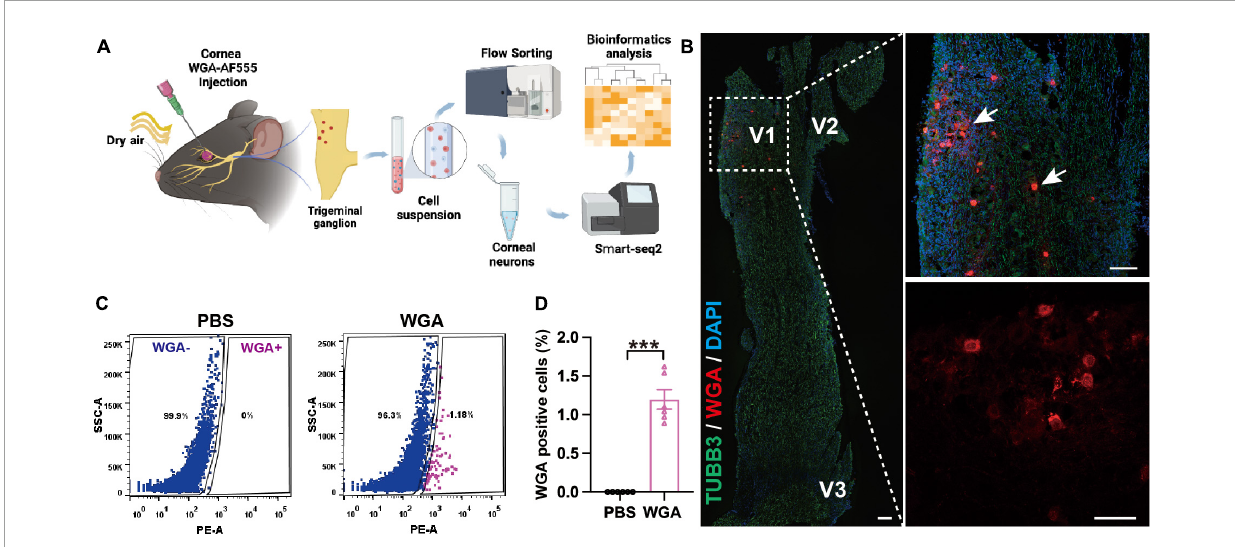
FIGURE3 Trigeminal ganglion (TG) corneal neurons in environmental dry eye disease mice sorted for RNA sequencing. (A) Procedure flowchart showing, that after corneal WGA-AF555 injection, the mice were given CDS treatment and then TGs were FACS sorted, followed by corneal neurons RNA sequencing application. (B) Representative images of retrograde WGA-AF555 (red, arrows) corneal neuron cell bodies in TG on day 3. Scale bars: 100 µ m. (C) Representative FACS images of WGA-AF555-positive corneal neurons in TG on day 3. Blue: WGA-AF555 negative cells, pink: WGA-AF555-positive cells. (D) The proportion of WGA-AF555-positive cells from a total TG population in the corneal WGA-AF555 injection ( n = 6) and PBS injection ( n = 6) groups. Data are represented as mean ± SEM; *** P < 0.001; WGA-AF555: wheatgerm agglutinin-Alexa Fluor 555, CDS, controlled dry system; eDED, environmental dry eye disease; FACS, fluorescence-activated cell sorting; TG, trigeminal ganglion; V1, ophthalmic branch; V2, maxillary branch; V3, mandible